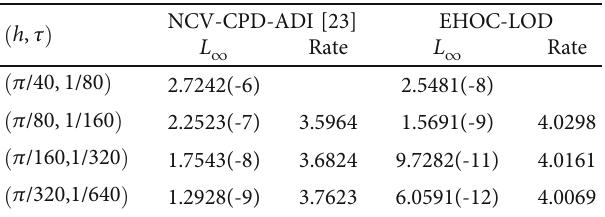
Table 6: L ∞ norm error and Rate when T = 1 with various for Example 3.